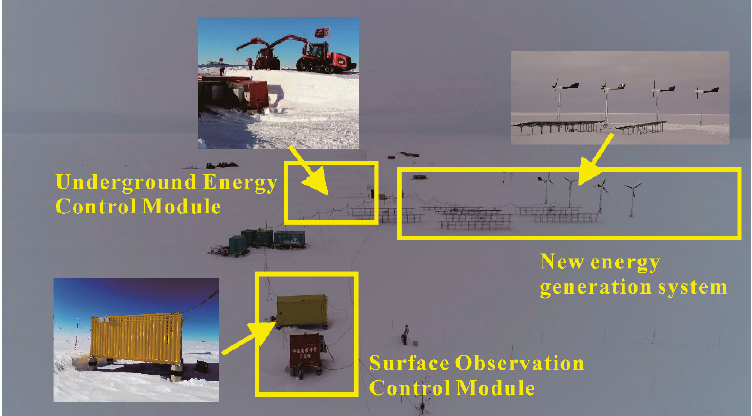
Figure 17. Aerial imagery of the entire Remote Control, Image Acquisition, Operation Maintenance, and Document Management (RIOD) system.